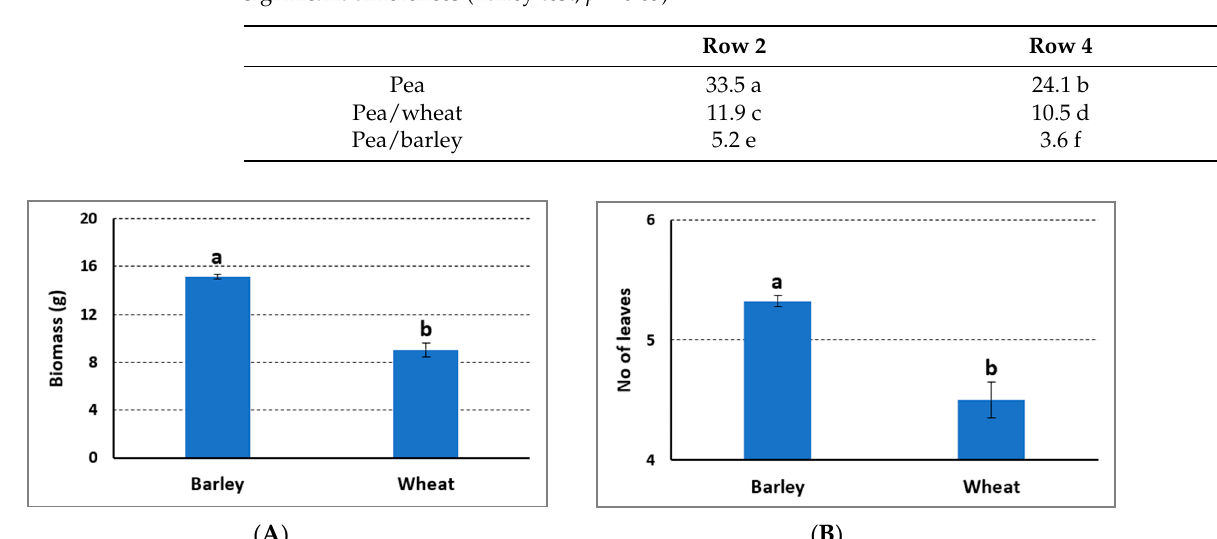
Table 6. Powdery mildew disease severity (%) on pea seedlings grown in rows 2 and 4 of the boxes. Different letters per treatment (pea monocrop, pea/wheat and pea/barley intercrops) mean significant differences (Tukey test, p < 0.05).